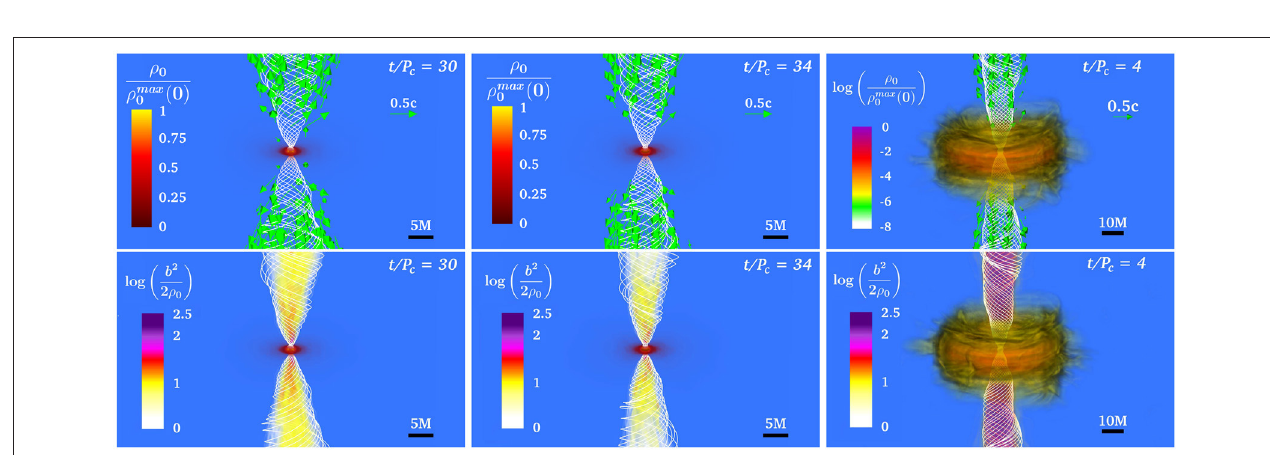
FIGURE 11 | Initial and final profiles of a dynamically stable ergostar modeled with the ALF2cc EOS (see Equation 8). The rest-mass density ρ 0 is normalized to its initial maximum value. The inner shaded torus indicates the position of the ergoregion. Here P c is the initial rotation period measured at the point where the rest-mass density is maximum (from Tsokaros et al., 2019b).